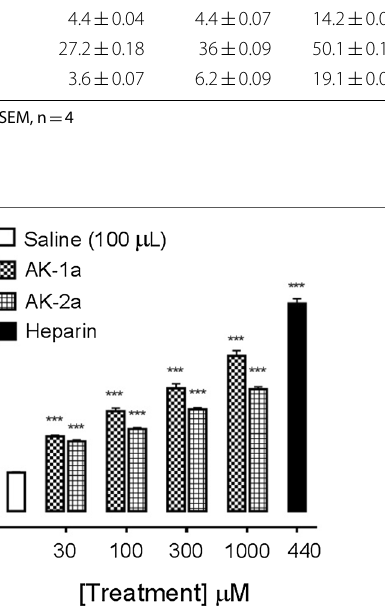
Fig. 16 Bar chart showing increase in plasma recalcification time (PRT) caused by different concentrations of (2 E ,5 E )‑2‑(4‑methoxybe nzylidene)‑5‑(4‑nitrobenzylidene) cyclopentanone (AK‑1a), (1 E ,4 E )‑ 4‑(4‑nitrobenzylidene)‑1‑(4‑nitrophenyl) oct‑1‑en‑3‑one (AK‑2a) and heparin. Data expressed as mean SEM, n 5, *** P < 0.001 vs. saline ± = group, one way ANOVA with post hoc Tukey’s